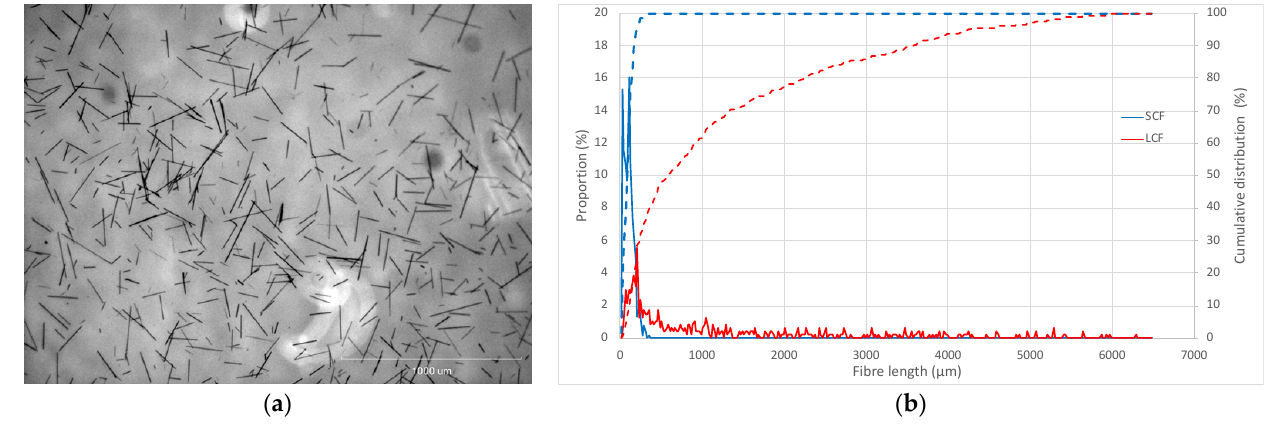
Figure 3. ( a ) Example micrograph of SCF material used for automated fibre length measurement ( b ) fibre length distributions for SCF and LCF material (solid (proportion), dashed (cumulative)).